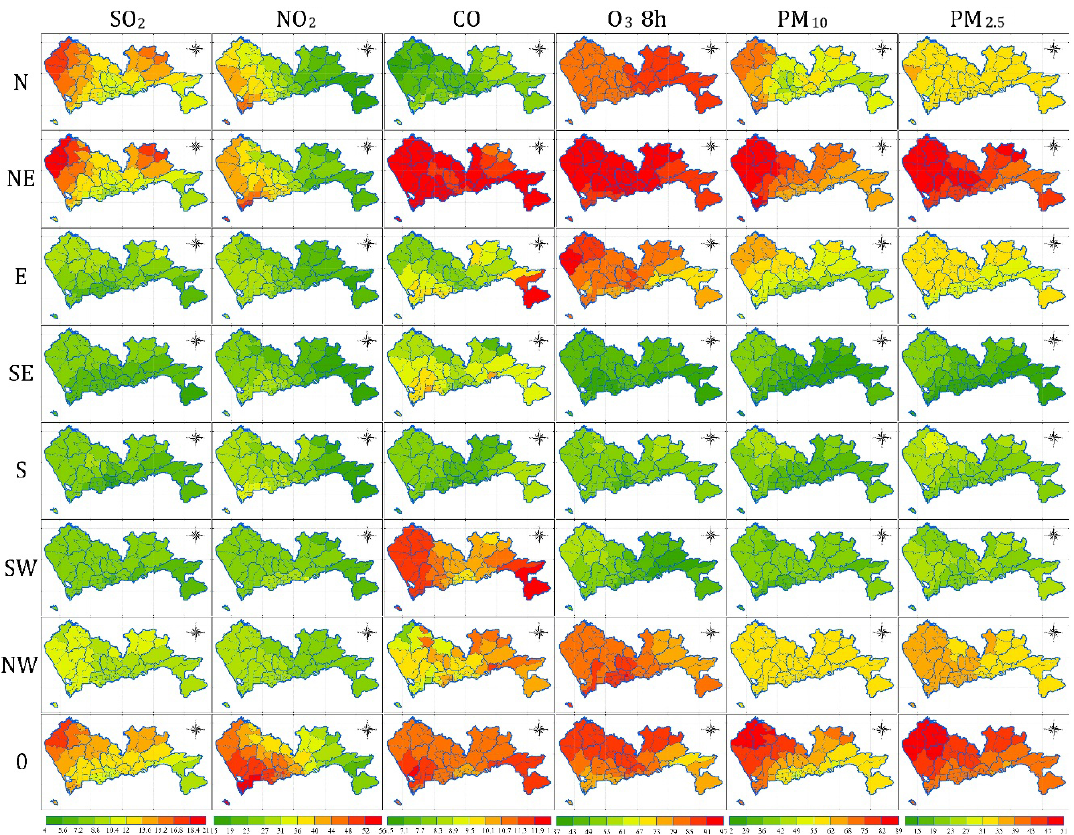
Figure 10. Spatial distribution of air pollutant concentrations based on wind direction classification in Shenzhen from March 2013 to February 2014.